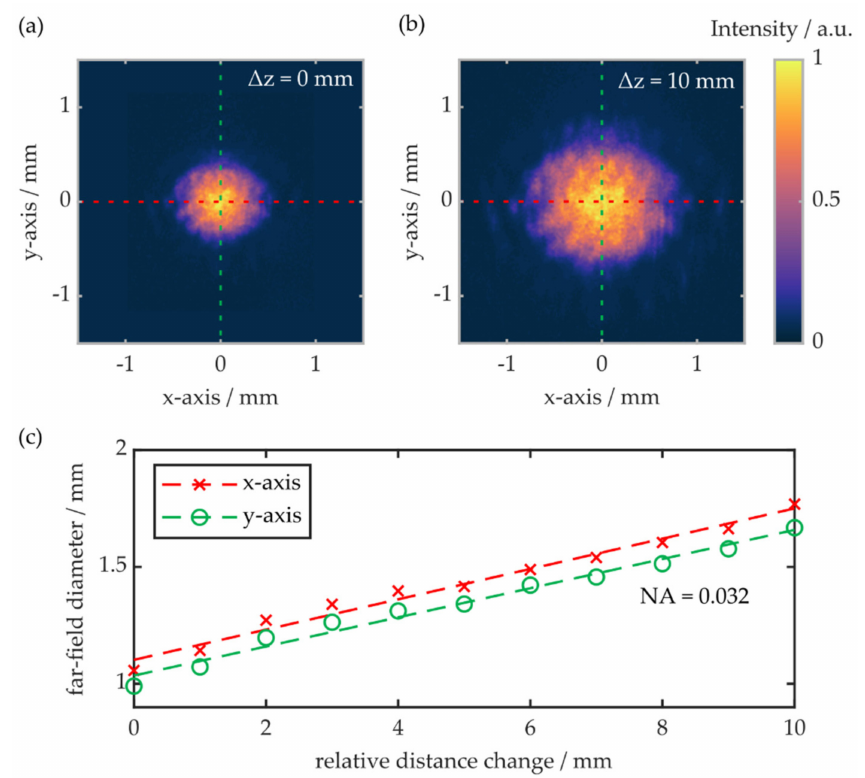
Figure 5. ( a ) Far-field image at a relative distance change ∆ z of 0 mm. ( b ) Far-field image at a relative dis-tance change ∆ z of 10 mm. ( c ) Respective far-field diameters in x- and y-direction as a function of the relative distance